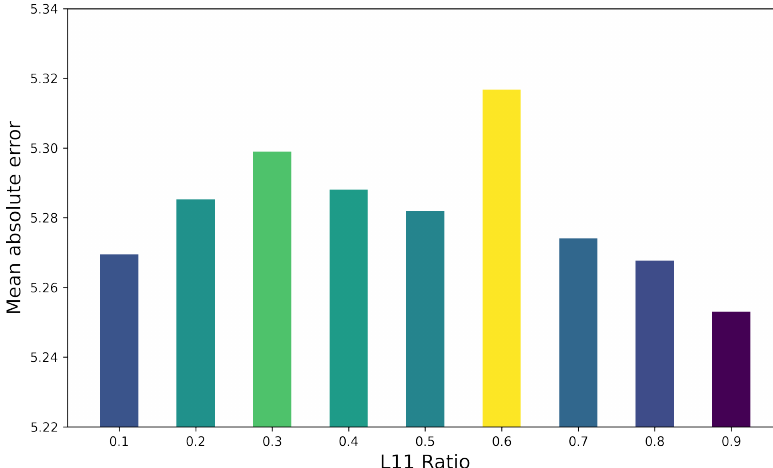
Figure 8. Impacts of L11 ratio on Estate